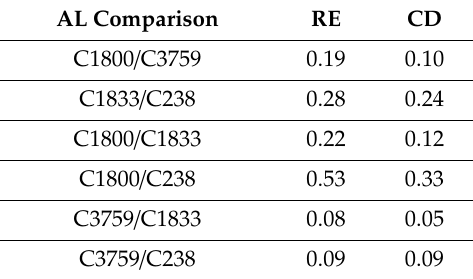
Table 2. Similarity calculations. Relative entropy (RE) and cosine distance (CD) values for comparison of cell distribution feature vectors are